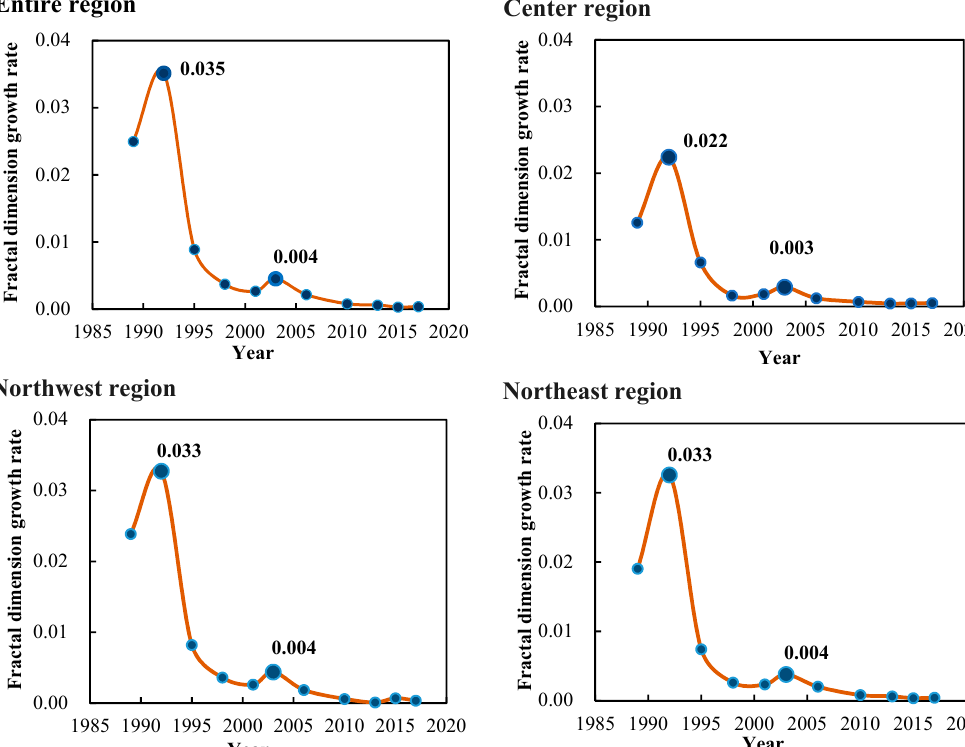
Figure 2. The graph of the growth rate of fractal dimension of four regions from 1986 to 2017.